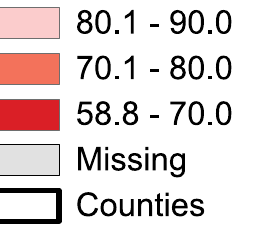
Fig 1. Percent of diabetic patients achieving HbA1c < 8.0%.